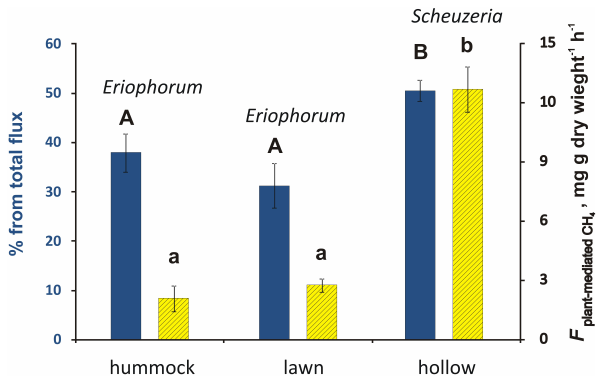
Fig. 3. Plant-mediated CH 4 flux (shown as % from total F CH y axis) and specific plant-mediated CH 4 flux per unit of biomass (in mg g dry weight − 1 , right y axis) estimated for E . vaginatum and S. palustris of three microform types as an average during the period of measurements. Errors are standard errors of measurement ( n = 3). Values followed by the same letters are not significantly different between microform types and plant species (uppercase letters for the left y axis, lowercase letters for the right y axis) at p ≤ 0 . 05 according to two-way-ANOVA and Fischer LSD